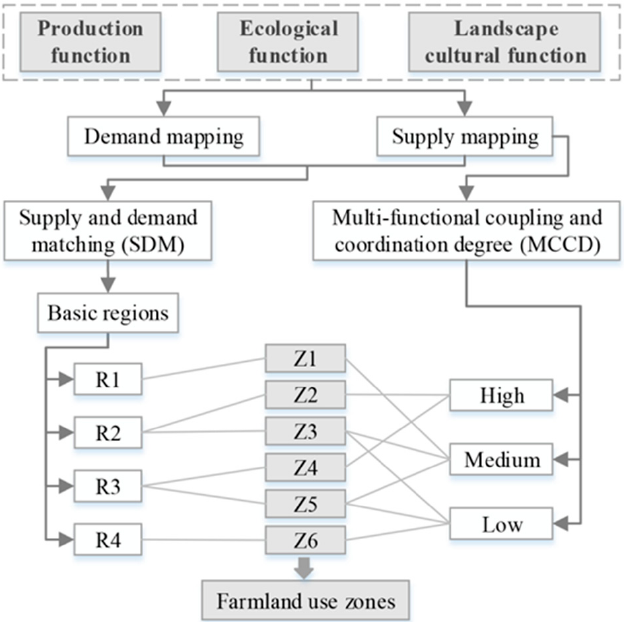
Figure 2. Flowchart of the division of the farmland-use zones in the present study.